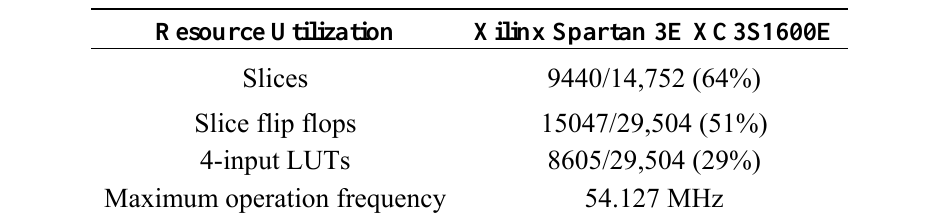
Table 6. Resource usage of the